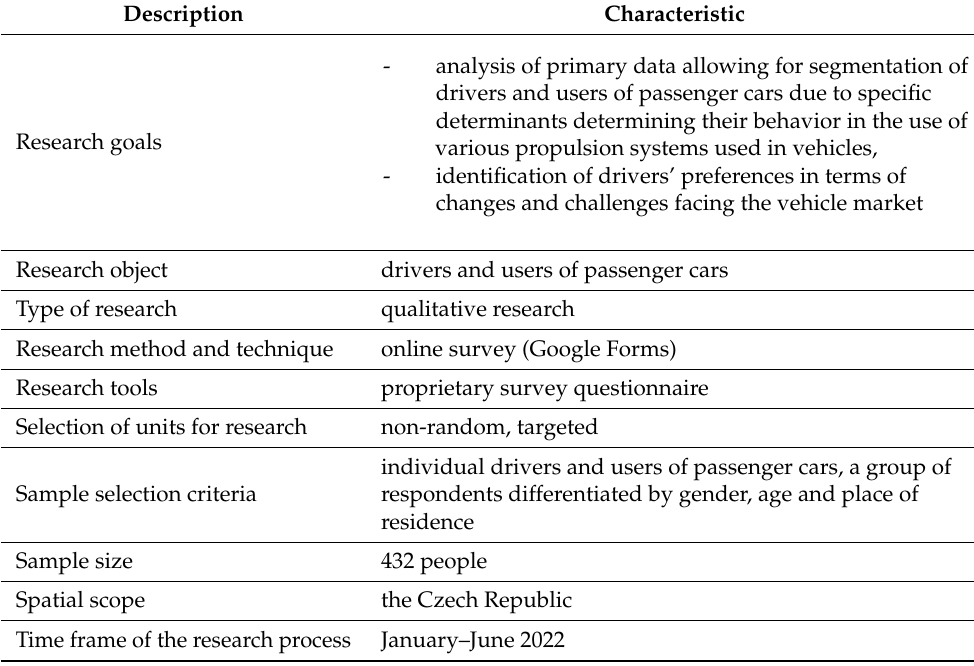
Table 1. Basic characteristics of the scope of the research conducted in the Czech Republic. Description